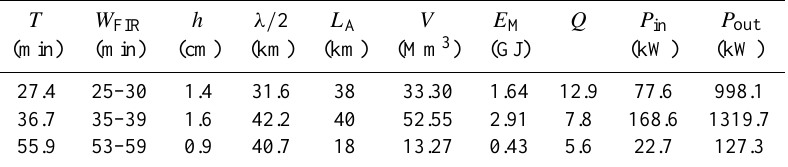
Table 7. Estimates of total energy and power generated by resonances in Monterey Bay. Modal amplitudes ( h ) are mean values from bandpass filtering the 17.8-year record of water levels at the NOAA tide gauge. T is the mode period, W FIR is the filter bandpass, λ/ 2 the mode half wavelength, L A the alongshore extent of the mode in the bay, V the volume of water displaced, E M the potential energy, Q the mode amplification, P in = E M /(QT ) the input driving power of the mode, and P out = E M /T the modal power. T W FIR h λ/ 2 L A V E M Q P in P out (min) (min) (cm) (km) (km) (Mm 3 )